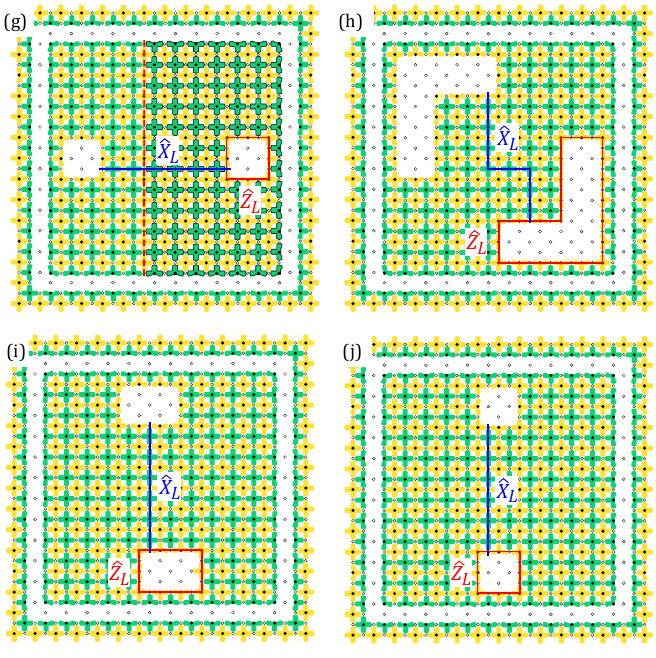
Figure 43: (continued from Fig. 42) (g) In the next surface code cycle, most of the X and Z stabilizers are turned back on, leaving two Z-cut enlarged holes and a ring, one stabilizer cell wide, isolating the 2D patch from the array, as in (a). The Z-cut holes are positioned so that the X chain ends on the internal boundary of each hole. The Z chain (dashed red line) is L L multiplied by all the black outline Z stabilizers, leaving a Z loop (solid red line) that encloses L the right Z-cut hole. (h) In the subsequent surface code cycle, and the first step of returning the Z-cut holes to original locations, the Z-cut holes are expanded and Z and X modified accord- L L ingly. This move is split in two steps to preserve the distance d during this process; the process pauses here for d surface code cycles to establish all values in time. (i) In the second step of returning the Z-cut holes to their original locations, the Z-cuts are expanded to encompass the original positions. The stabilizer measurements are performed twice. (j) In the final step, the cuts are reduced to their original size, as in Fig. 41. This stabilizer measurement pattern is ap- plied three times (see Ref. Ref. (Fowler, Mariantoni, Martinis and Cleland, 2012a)). Following this, the isolated patch is reconnected by turning on the appropriate stabilizers. Figure from Ref. (Fowler, Mariantoni, Martinis and Cleland,